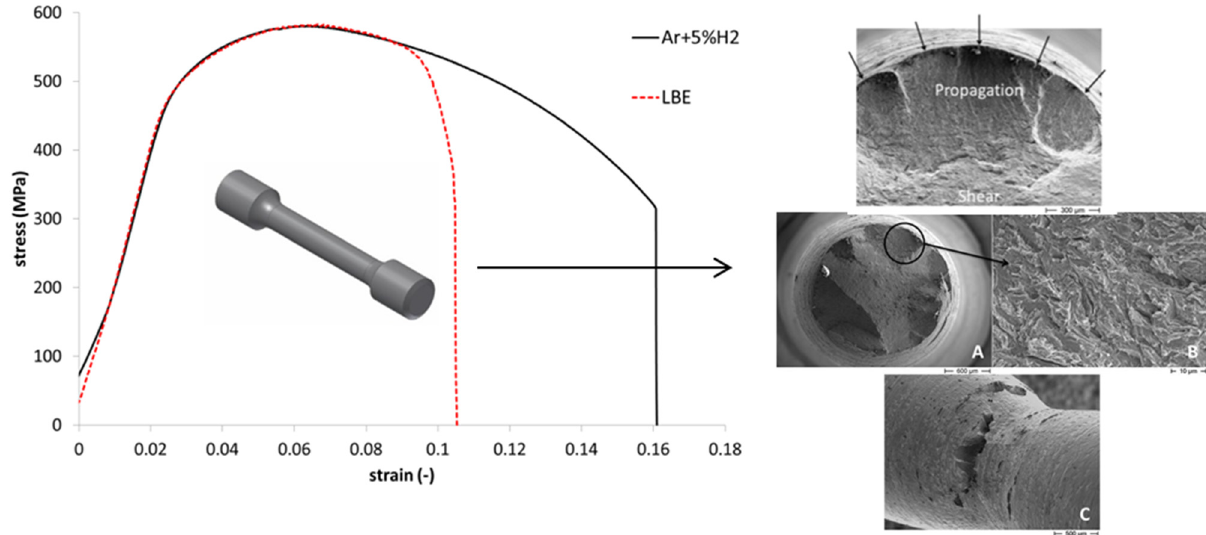
Fig. 3. Stress – strain curves of a T91 f/m steel tested in tension in Ar+5%H 2 and oxygen-poor ( C O ≈ 10 (cid:1) 9 – 10 (cid:1) 10 mass%) static liquid LBE. Both tests were conducted at 350 ° C under an applied strain rate of 5 (cid:3) 10 (cid:1) 5 s (cid:1) 1 . The specimen tested in LBE was pre-exposed at 450 ° C in low-oxygen liquid LBE. The fracture surface of the specimen tested in LBE (A) shows areas that suffered quasi-cleavage (B) failure. Also, the inspection of the specimen necking region shows the formation of numerous side cracks